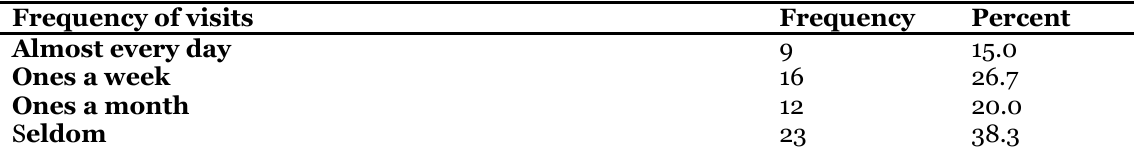
Frequency of Visits Frequency of visits Frequency Almost every